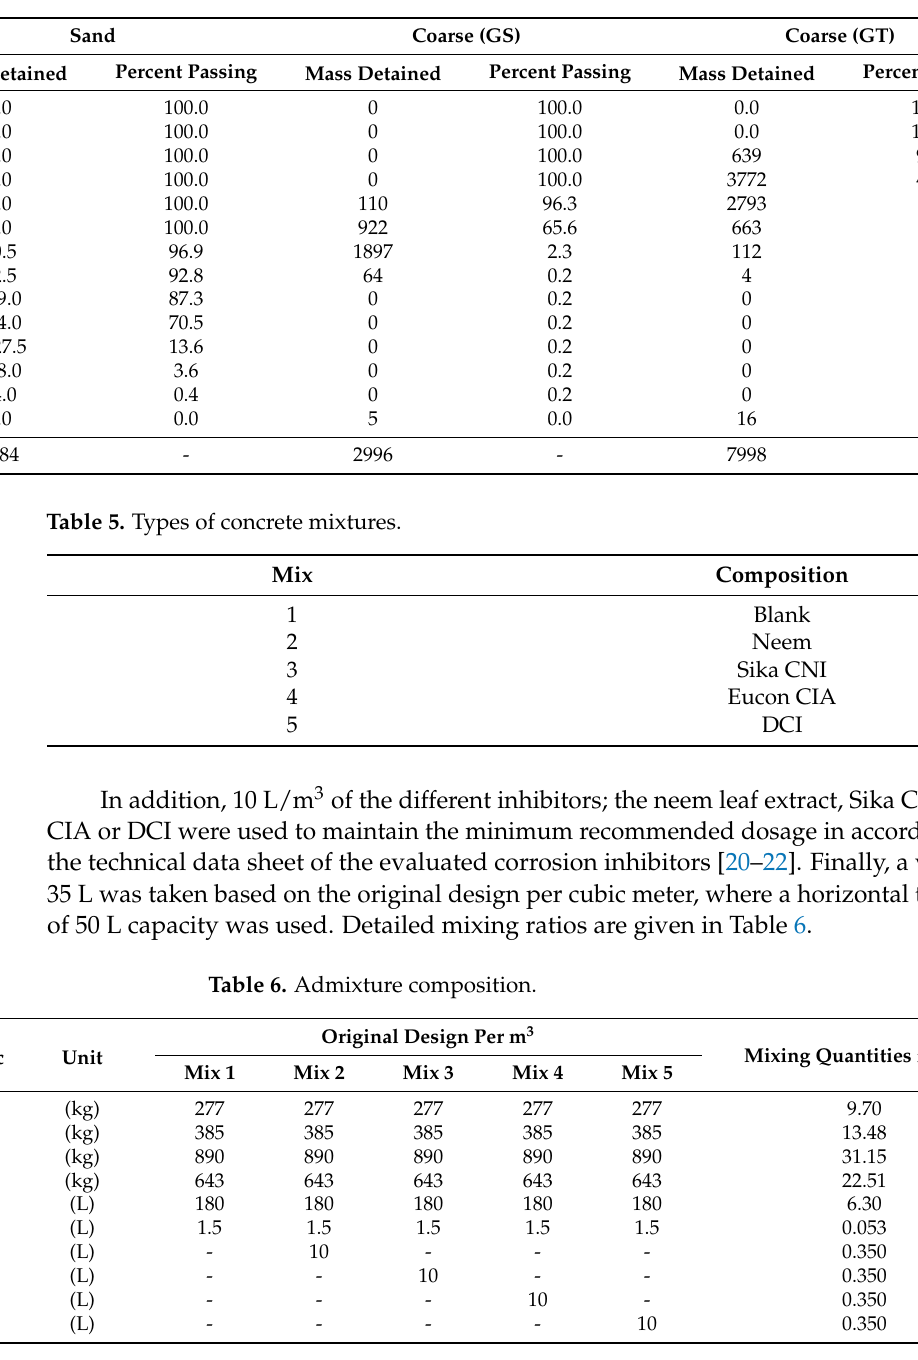
Table 4. Aggregates granulometric analysis.